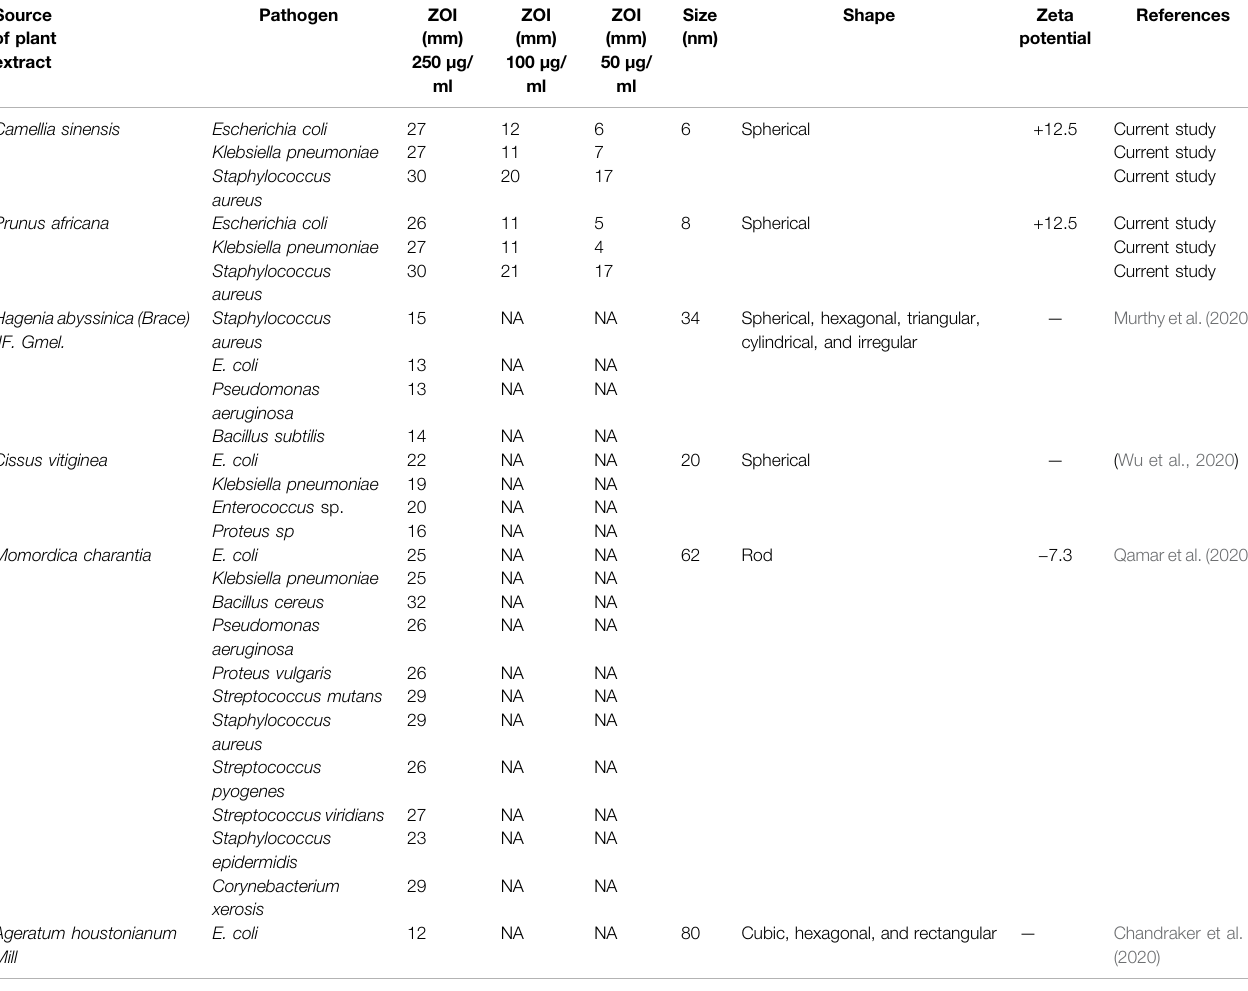
TABLE 4 | Comparative statistics of antimicrobial activities, size, shape, and zeta potential of copper nanoparticles synthesized by using various plant. Source of plant extract